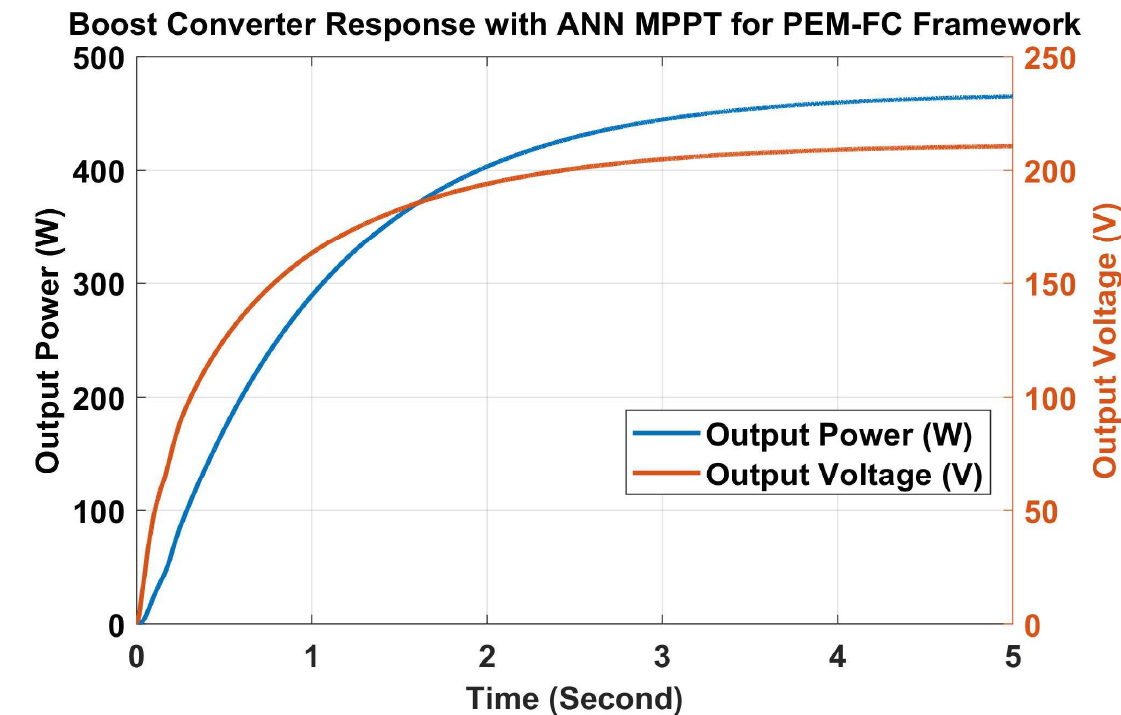
Figure 26. Output Power and Voltage of Boost Converter with AN-N Technique for PEM-FC Frame- work.